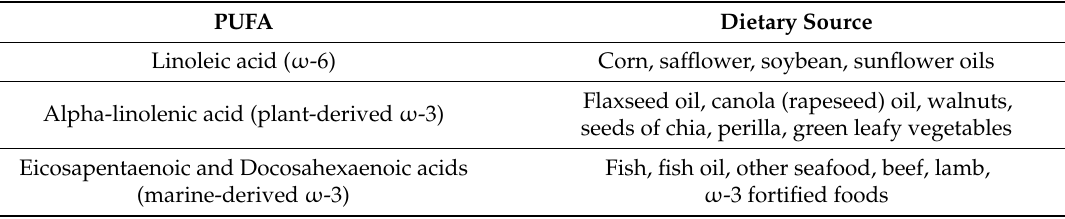
Table 1. Dietary sources of major PUFAs.